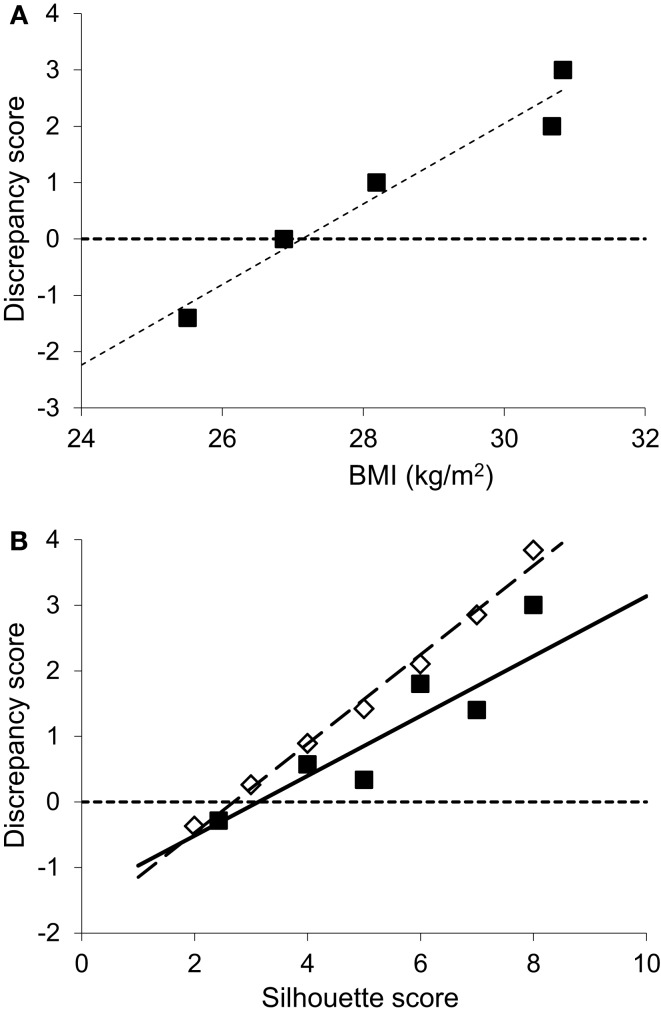
Discrepancy between current and ideal body shape from body shape silhouettes. (A) Discrepancy (current minus ideal) silhouette score groups, shown according to the corresponding current mean BMI for that group (groups with scores 1 and 2 were small so were conflated), showing higher discrepancy scores correspond to higher BMI’s (r = 0.37, intercept 26.9 kg/m2, P < 0.01, n = 47). (B) Filled squares: discrepancy scores by current silhouette score where higher silhouette score indicates greater adiposity (r = 0.61, P < 0.001, n = 47). Comparison is made with normative data (open diamonds) from a large Caucasian population (n = 16,728) (41).